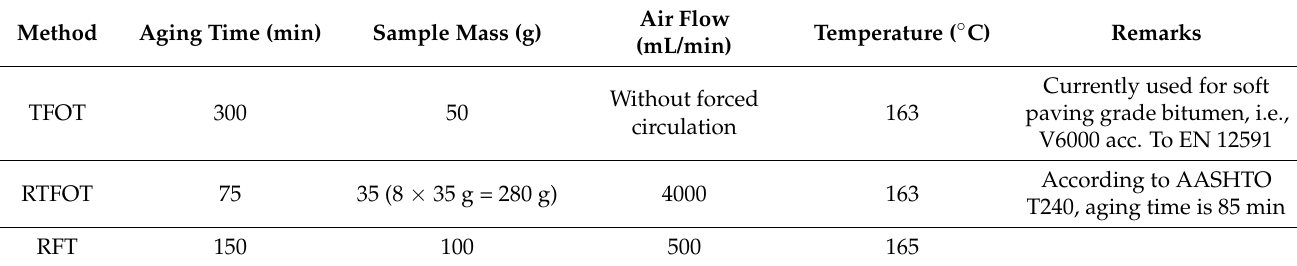
Table 1. Conditions for short-term aging of bitumen using the three methods described in European